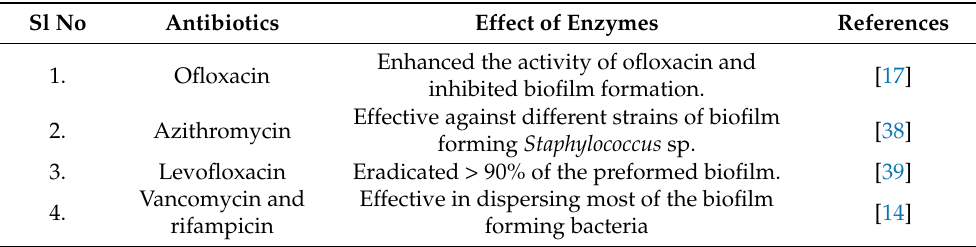
Table 1. Synergistic property of enzyme with different